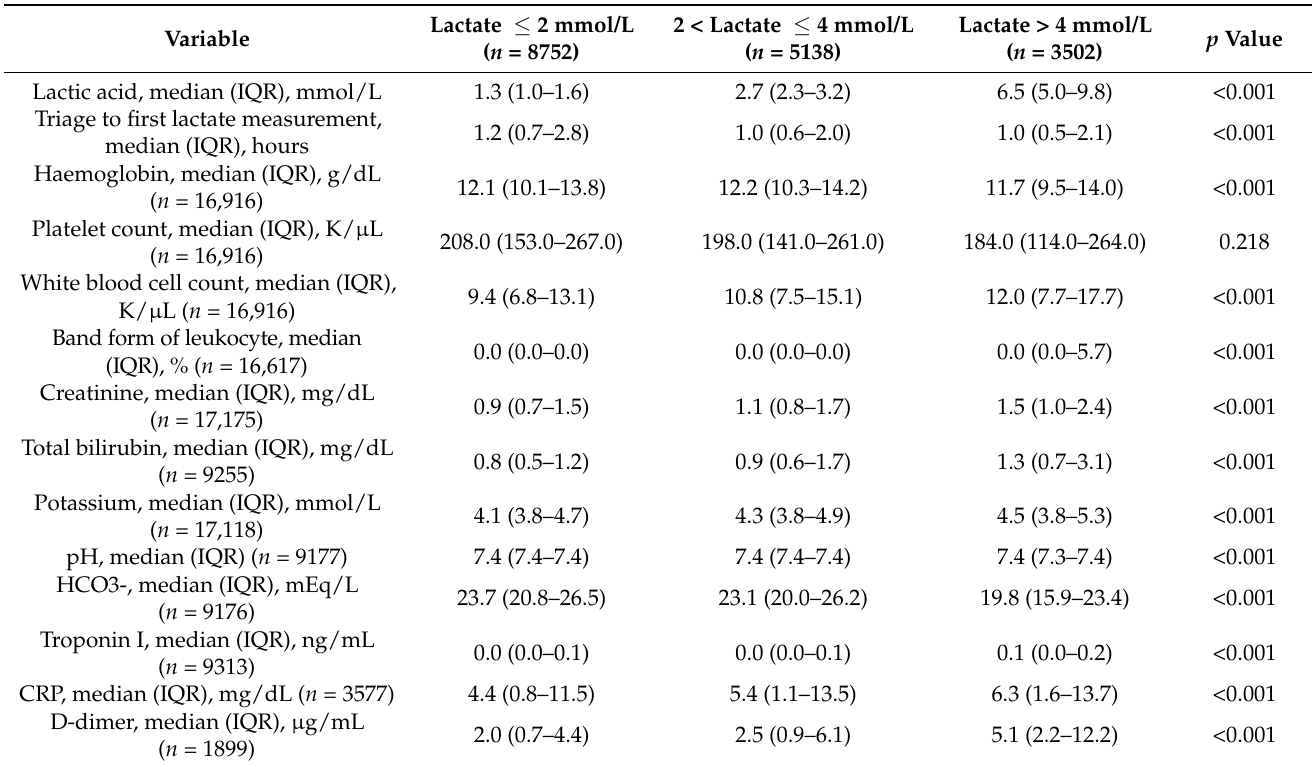
Table 2. Laboratory markers by the lactate